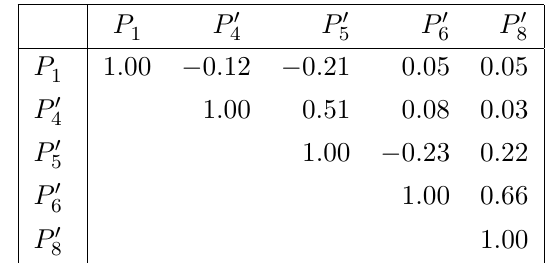
) parameters obtained for q 2 2 [2 : 0 ; 4 : 0] GeV 2 . 0